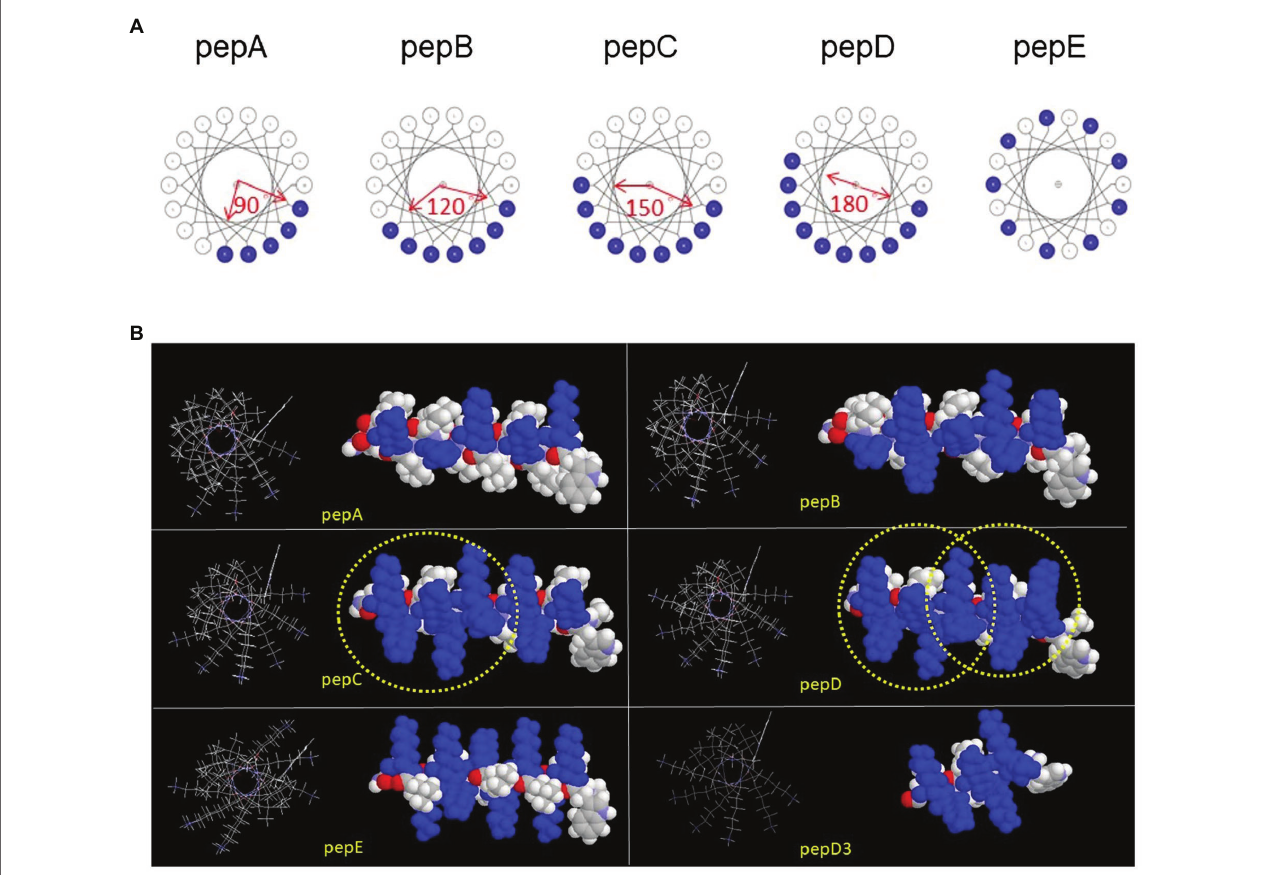
FIGURE 1 | Designs and structural models of the de novo designed peptides. (A) Designs and structural models of the de novo designed peptides with different charge distribution patterns. (B) Structural models of the peptides in an α -helical conformation. The left image is the wireframe model of the helical wheel, and the right image is the space-filled model from the side of the helix. Lysine is colored blue. The “BBHBBHHBBH” sequence pattern is circled in pepC and